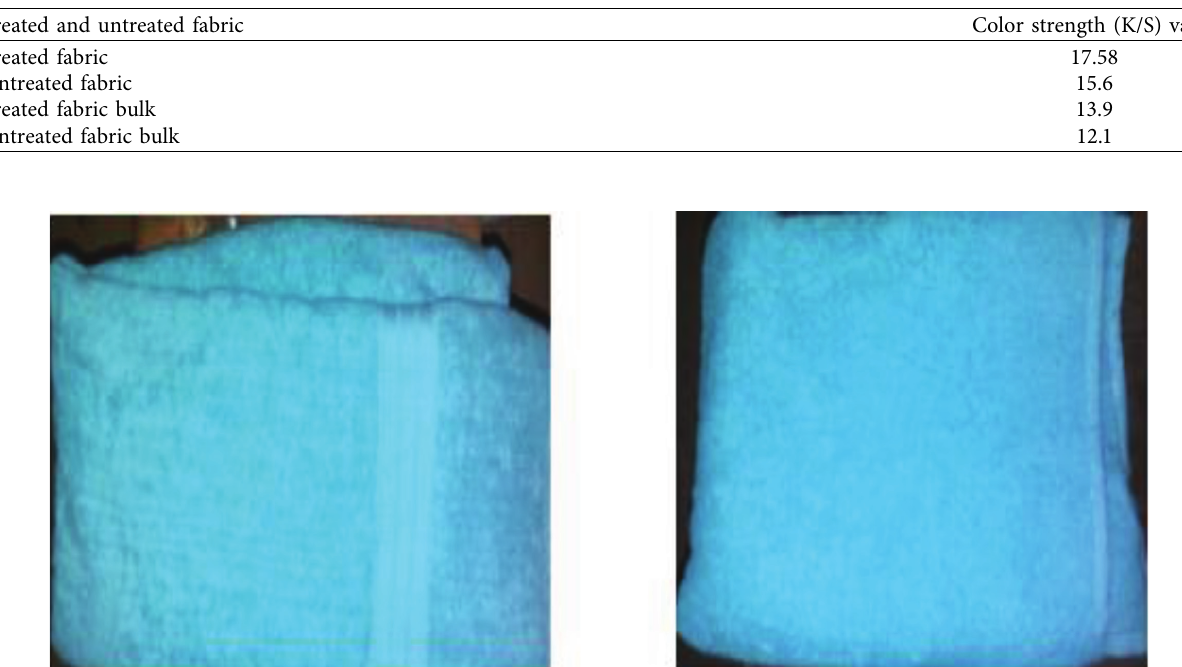
Table 6: K/S values of dyed, treated, and untreated fabric.